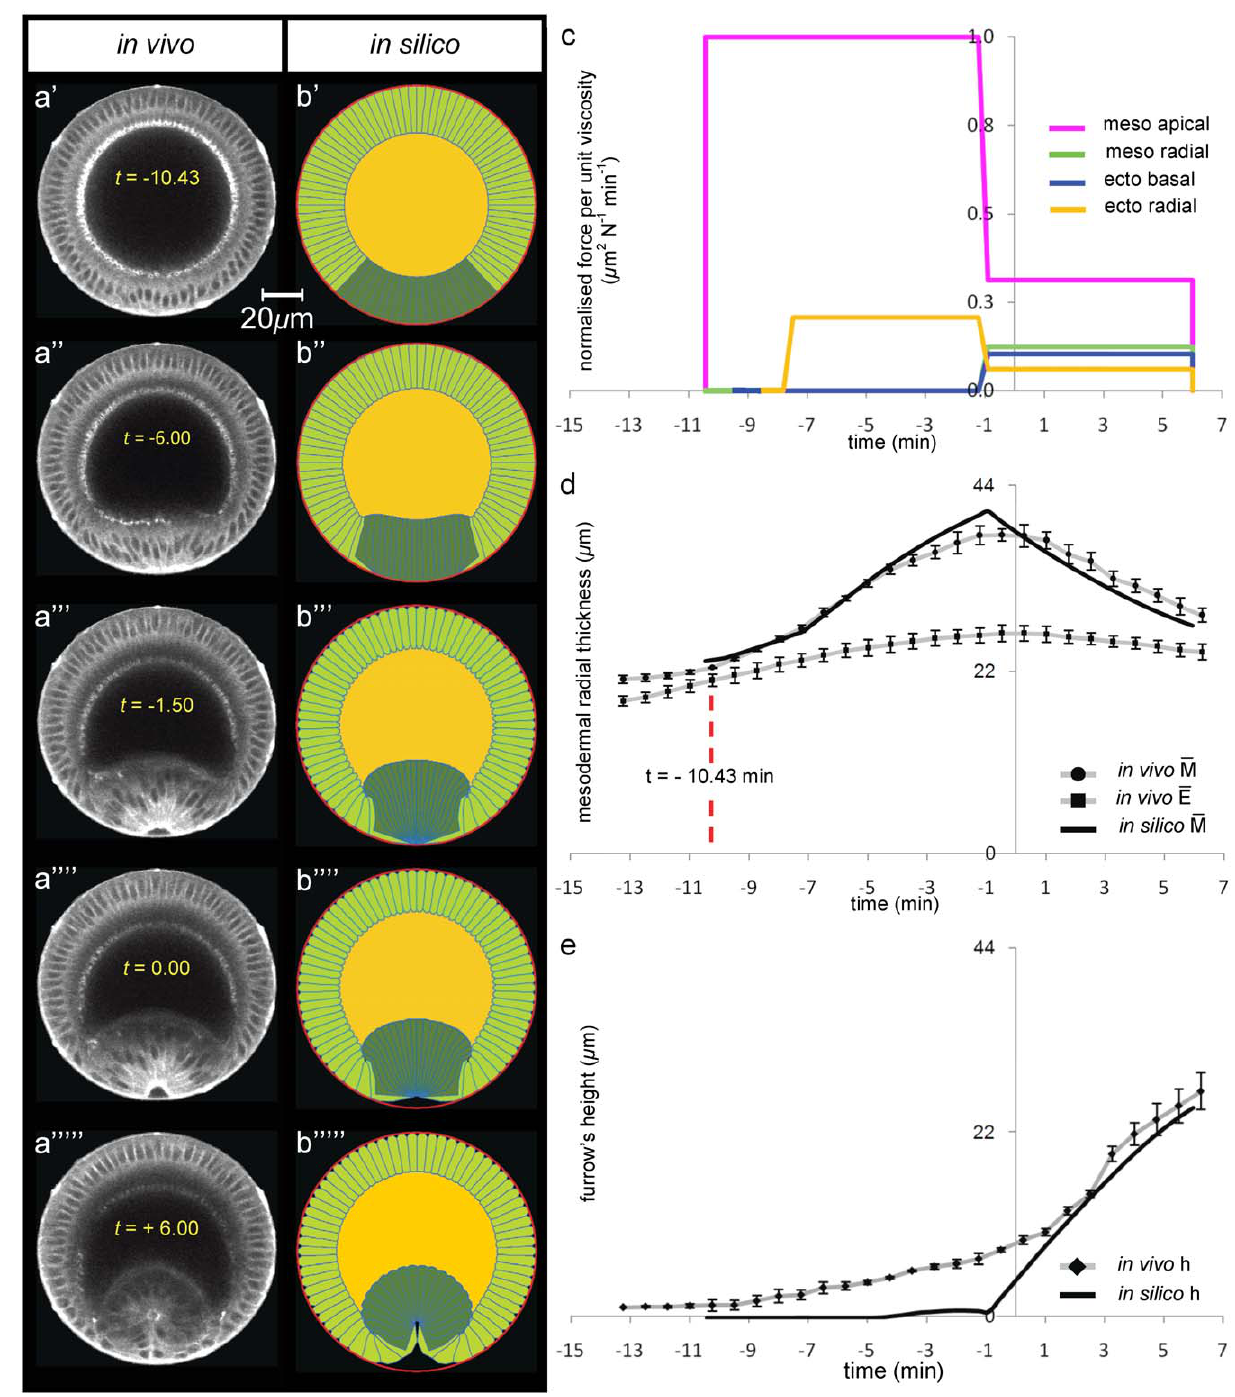
Figure 4. Modelling ventral furrow invagination: bnt -mutant genotype. Selected multi-photon images of in vivo transverse cross-sections of a bicoid , nano , torso -like mutant embryo during ventral furrow formation. bnt -mutant has germ-band extension and posterior mid-gut invagination suppressed. The embryo is labelled with Sqh-GFP and oriented with its dorsal surface upward (Fig. 1a). Time interval between successive frames is 45 sec and instant zero was set by using apical-basal cell height profiles on the dorsal side (Fig. S2b). ( a ) Selected multi-photon images (columns) of in vivo transverse cross-sections of a bnt -mutant embryo during ventral furrow formation. The embryo is labelled with Sqh-GFP and is oriented with its dorsal surface upward (Fig. 1a). The time interval between successive frames is 45 sec. Time zero was set by using apical-basal cell height profiles on the dorsal side (see panel d). ( b ) Selected frames (columns) of in silico transverse cross-section of a bnt -mutant genotype. Embryo’s 2D geometry is oriented with its dorsal side upward. The undeformed initial configuration (panel b 9 ) corresponds to in vivo deformations at t= 2 10.43 min (see panel d). ( c ) In silico force distributions utilised to simulate invagination in b). ( d ) Time-trends of average radial mesodermal ( (cid:2) MM ) and ectodermal ( (cid:2) EE ) thicknesses of the epithelium (see schematic in Fig. 3e). ( e ) Time-trends of furrow’s height h at the ventral side (see schematic in Fig. 3e).